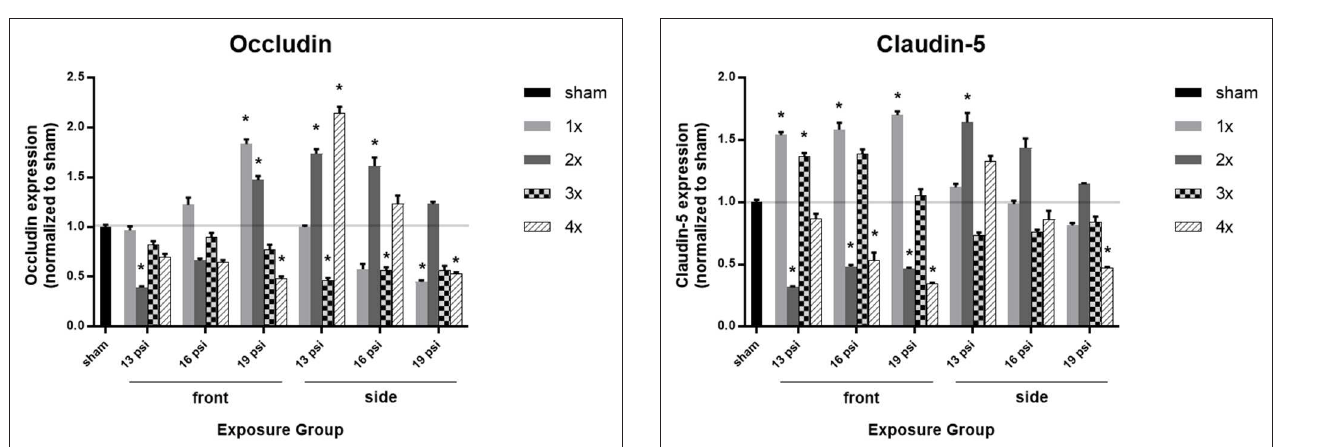
FIGURE 3 | Quantification of occludin expression measured by Western blot. Results presented as blast intensity for each orientation (front vs. side). Values normalized to sham. Statistical significance compared to sham: * p < 0.05 (Significance values in Supplemental Table 2 ). Data is expressed as mean ± SEM, normalized to sham. Representative Westerns shown in Supplemental Figure 1 .